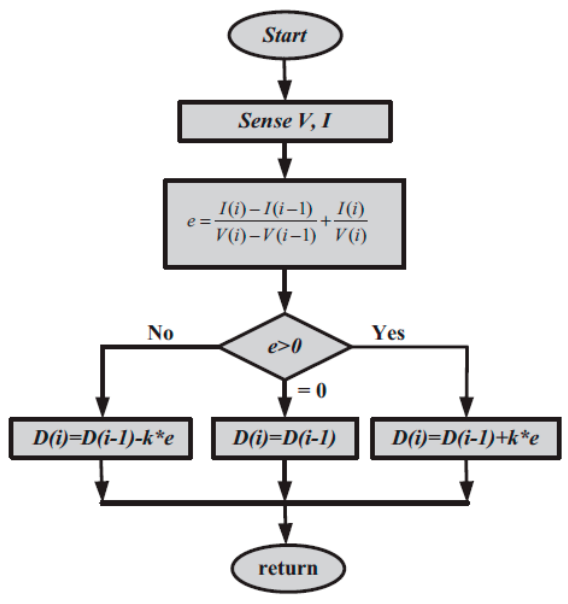
Figure 6. INC method flowchart.